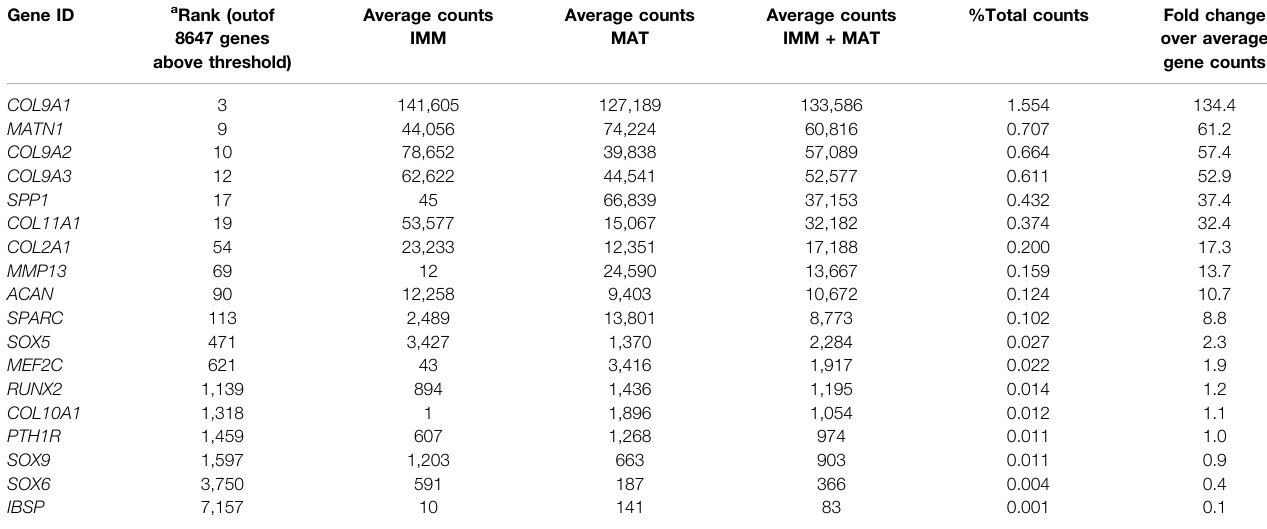
TABLE 1 | Normalized gene expression counts of relevant cartilage genes in chick